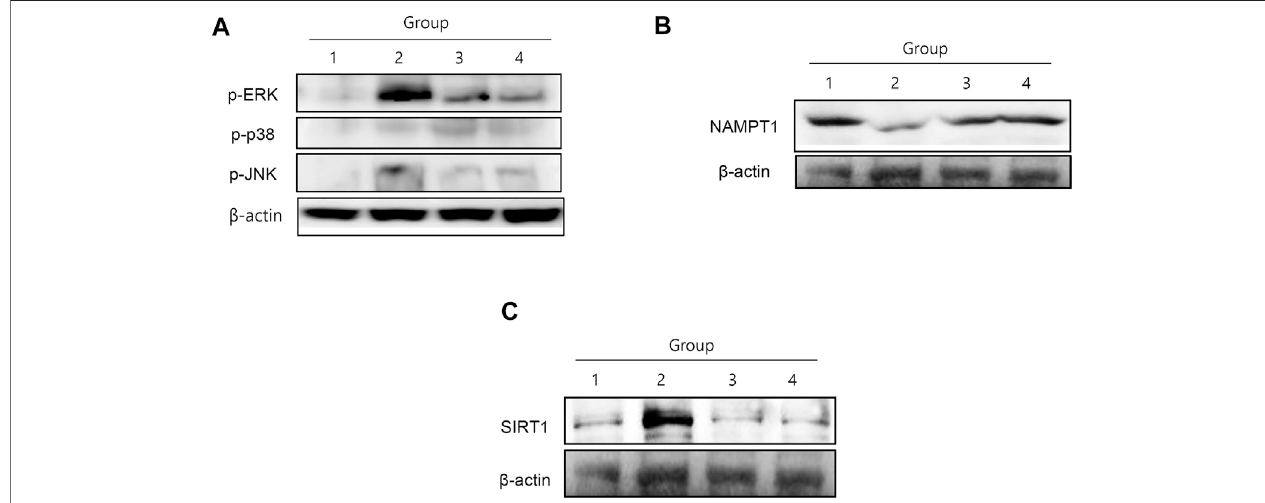
FIGURE 3 | MAPKs, NAMPT, and SIRT1 changes according to the group. (A) C26-induced cancer cachexia was associated either ERK and JNK activation, then NR administration signi fi cantly inactivated these cachexia-associated MAPKs. (B) NAMPT1 was signi fi cantly decreased in cancer cachexia group, suggesting